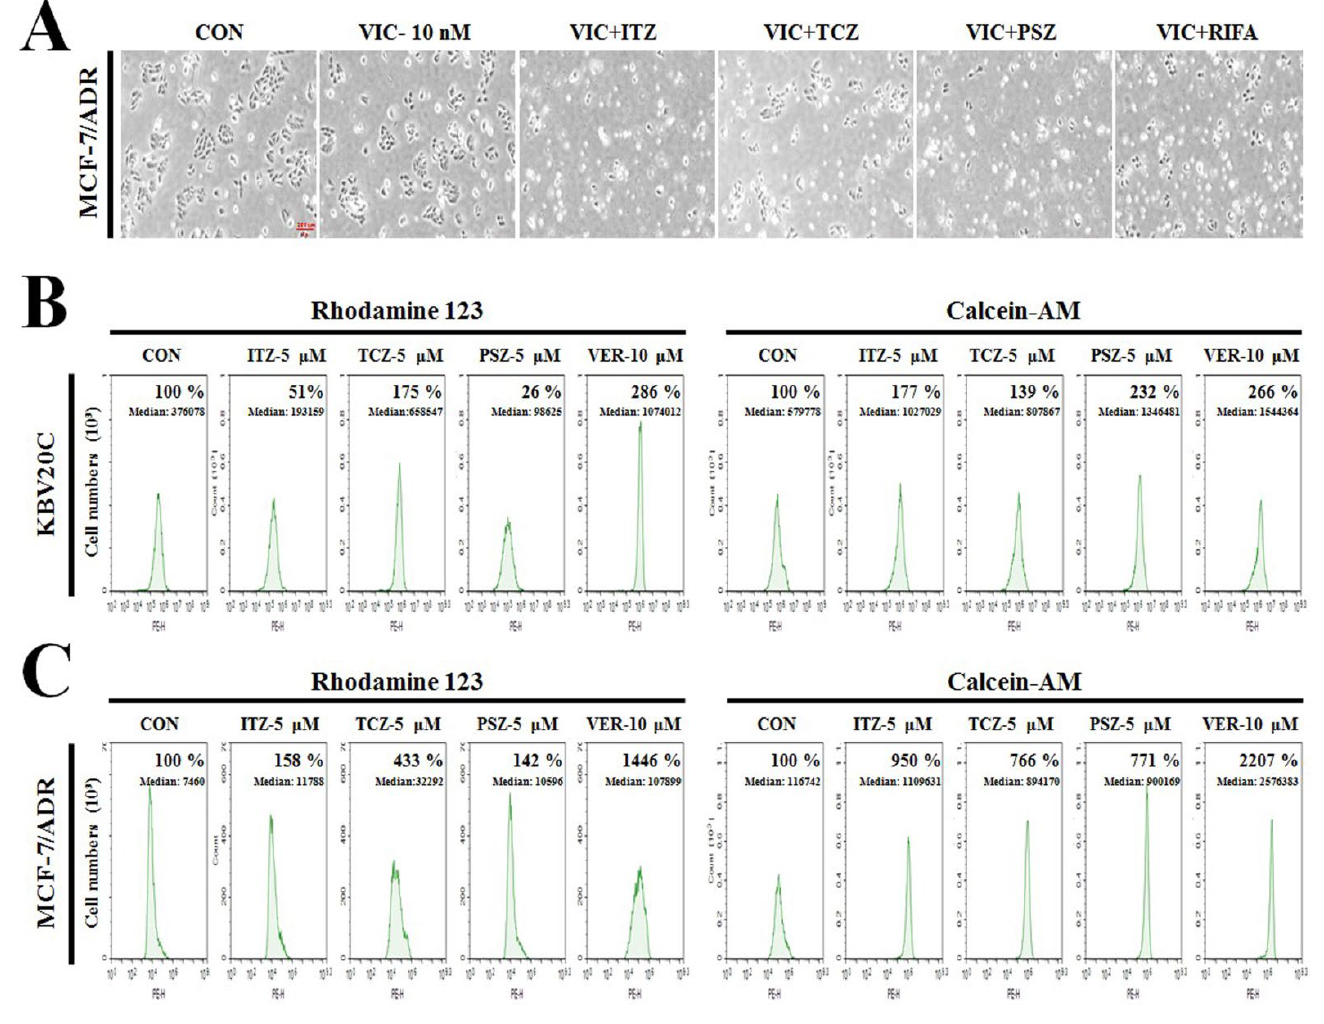
Figure 5. TCZ, itraconazole, and posaconazole exhibit high P-gp inhibitory activity in calcein-AM substrate efflux assays ( A ) P-gp-overexpressing drug-resistant MCF-7/ADR cells were treated with 10 nM VIC, 10 nM VIC with 5 μM itraconazole (VIC + ITZ), 10 nM VIC with 5 μM TCZ (VIC + TCZ), 10 nM VIC with 5 μM posaconazole (VIC + PSZ), 10 nM VIC with 5 μM rifabutin (VIC + RIFA), or 0.1% DMSO (CON). After two days, all cells were observed using an inverted microscope at ×100 magnification. ( B ) KBV20C cells were treated with 5 μM itraconazole (ITZ), 5 μM TCZ, 5 μM posaconazole (PSZ), 10 μM verapamil (VER), or 0.1% DMSO (CON). After 1 h, all cells were stained with rhodamine 123 (left panel) or calcein-AM (right panel) for 3 h and examined by using FACS analysis as described in Materials and Methods. ( C ) MCF-7/ADR cells were treated with 5 μM itraconazole (ITZ), 5 μM TCZ, 5 μM posaconazole (PSZ), 10 μM verapamil (VER), or 0.1% DMSO (CON). After 1 h, all cells were stained with rhodamine 123 (left panel) or calcein-AM (right panel) for 3 h and examined by using FACS analysis as described in Materials and Methods.